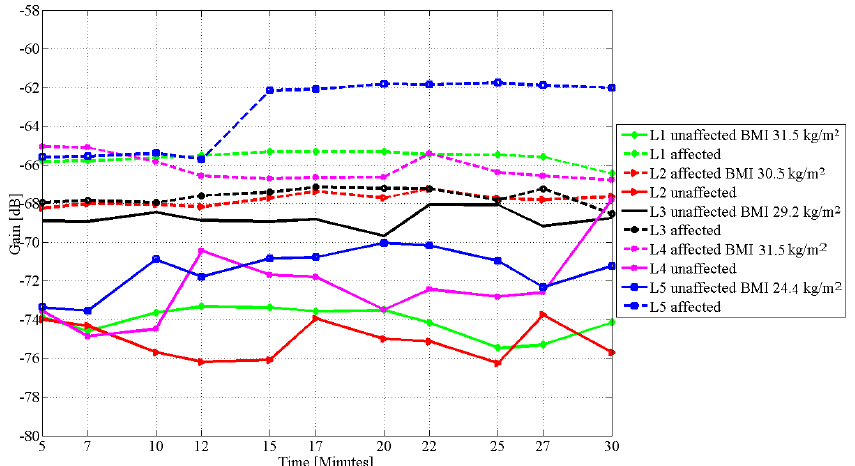
Figure 3. Measurement of galvanic coupled signal gain at 900 kHz, on both arms of lymphoedema affected subjects without fluid